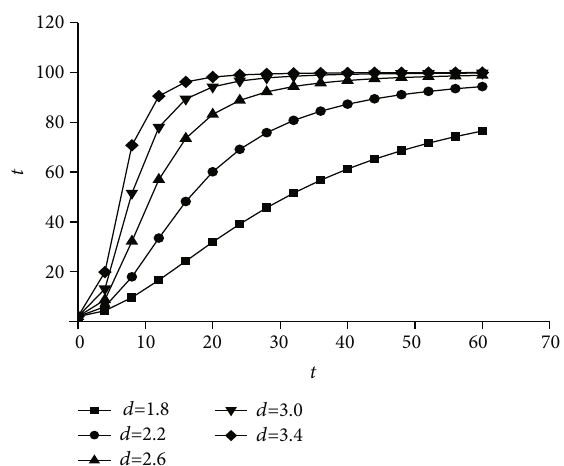
Figure 2: Flexibility of MMF model